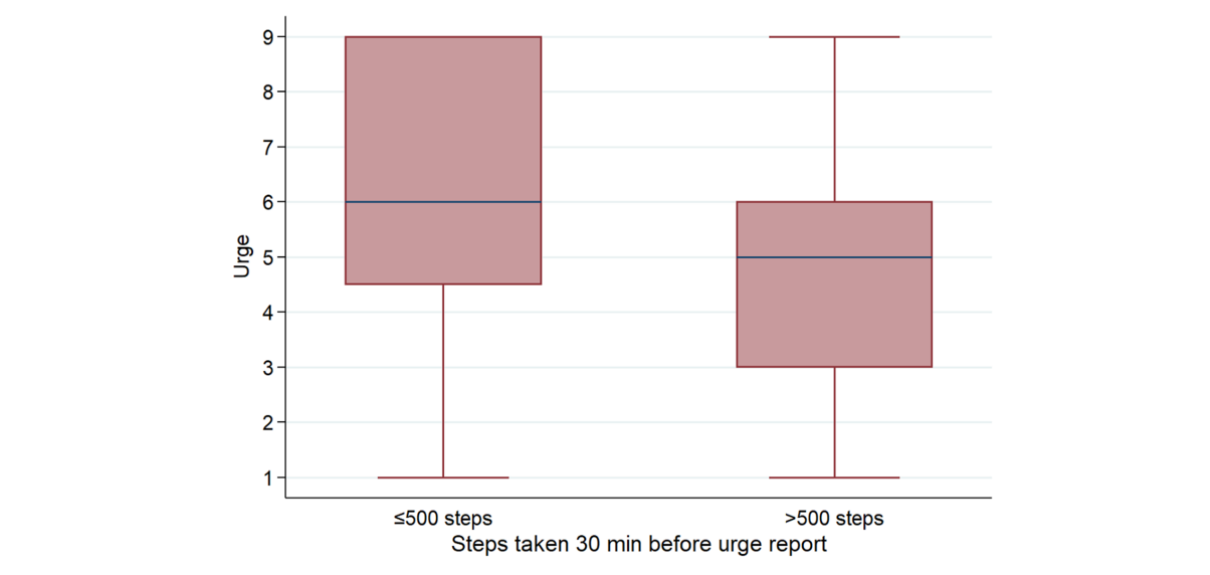
Figure 4. Boxplot of urge for the 6 “extreme responders,” stratified by episodes in which ≤ 500 or >500 steps were taken in the 30-min time window before an urge report.